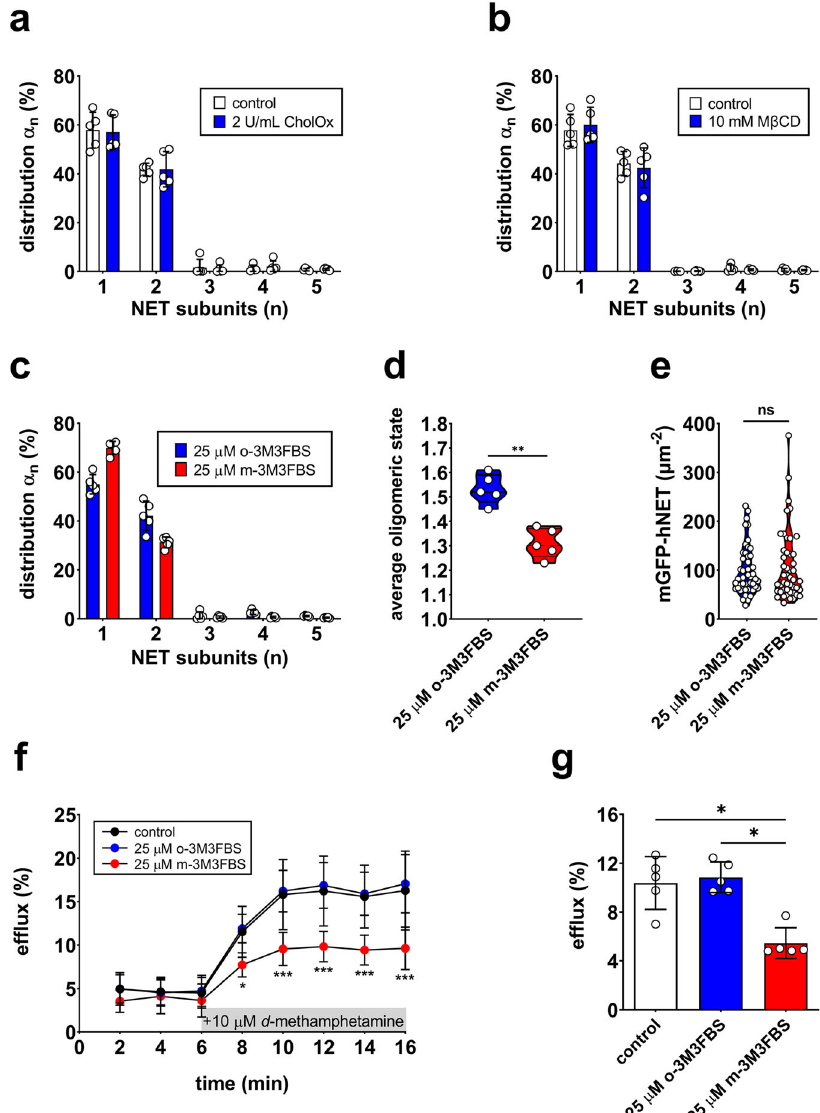
Fig. 3 Effect of cholesterol and PIP 2 on NET oligomerization and function. Oxidation ( a ) and depletion ( b ) of membrane cholesterol did not affect NET oligomerization. Each data point shows an independent experiment with TOCCSL runs on ten cells. Bars represent means ± SD. c NET oligomerization after PIP 2 depletion with the direct PLC activator m-3M3FBS and after treatment with its inactive analog o-3M3FBS. Each data point represents an independent experiment with TOCCSL runs on ten cells. Bars represent means± SD. d PIP 2 depletion resulted in a signi fi cantly decreased average oligomeric state (** P < 0.01). e Surface density of mGFP-hNET after m-3M3FBS or o-3M3FBS pretreatment was statistically indifferent. f NET-mediated substrate ef fl ux over time, induced with 10 µ M d -methamphetamine after 6 min. The data were derived from fi ve independent experiments (mean ± SD). Single data points are shown in Supplementary Fig. 6a. g Total d -methamphetamine-induced substrate ef fl ux was decreased under PIP 2 -depleted conditions. Bars represent mean ef fl ux (±SD) of fi ve experiments, normalized to basal ef fl